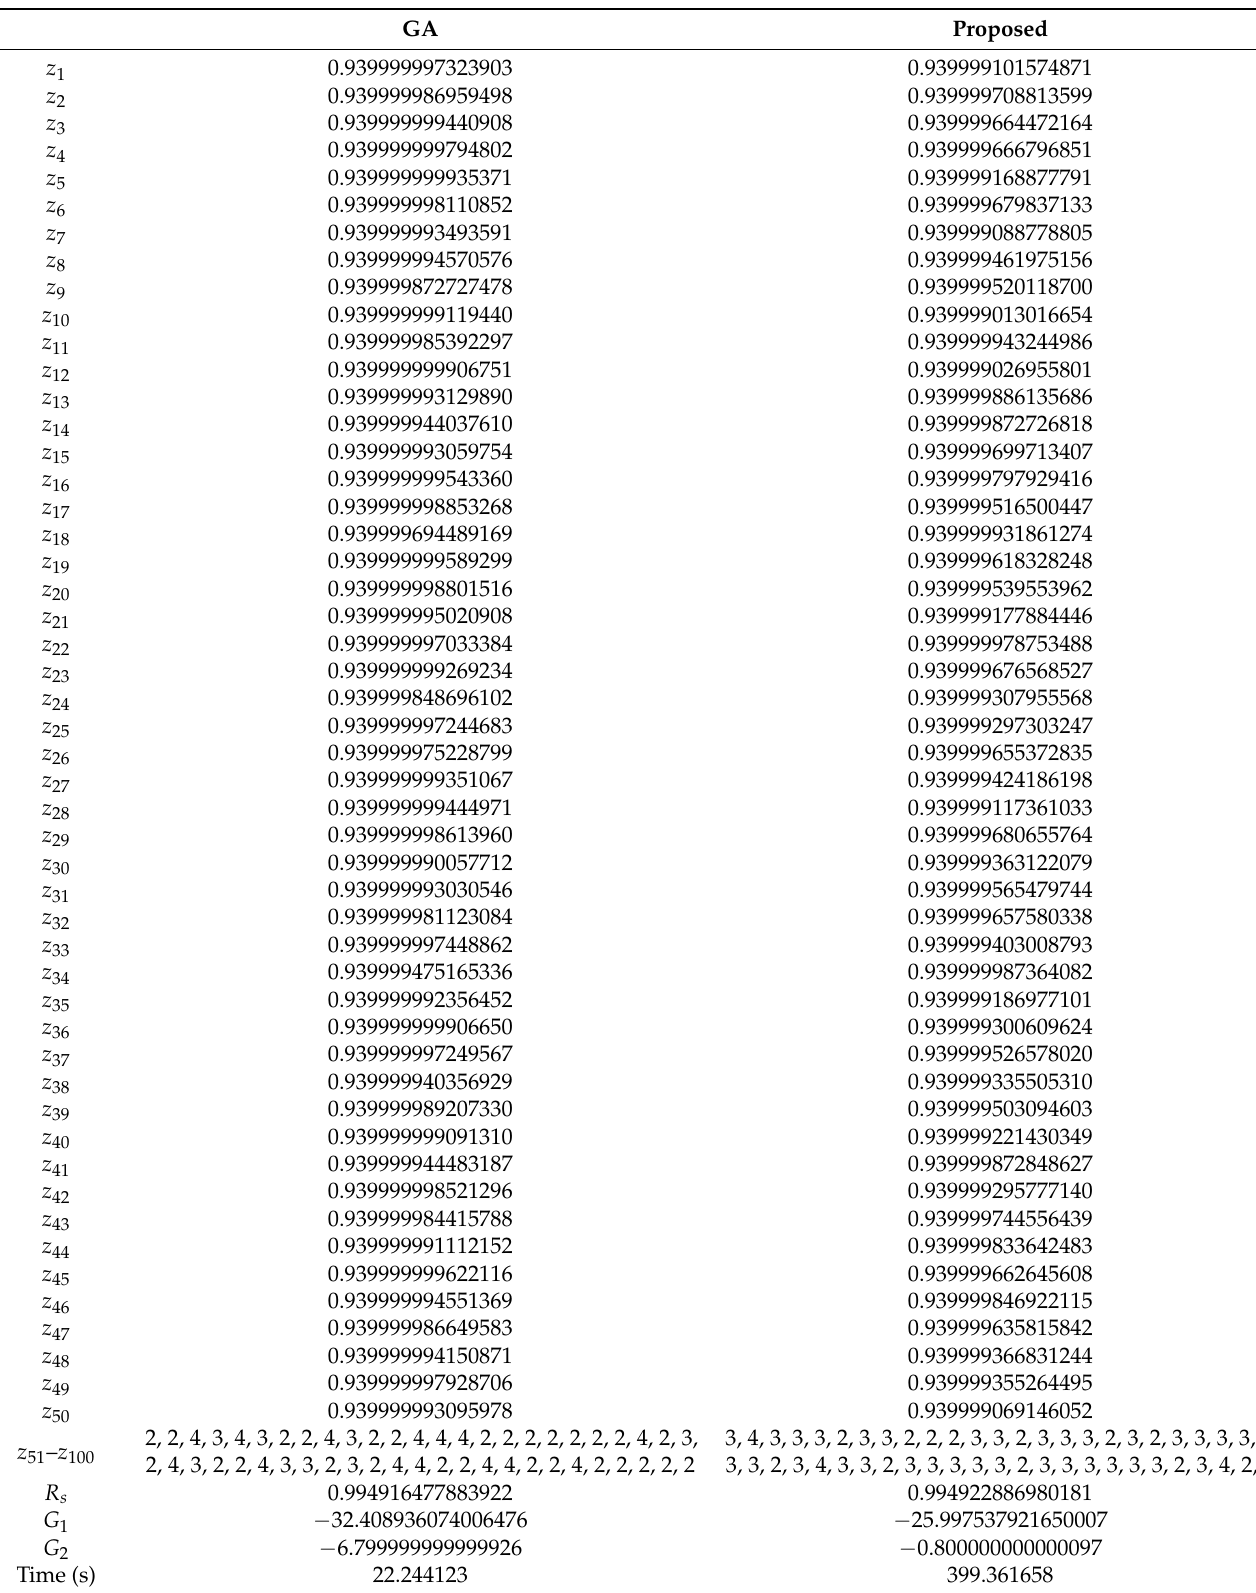
Table 2. Optimal solutions of the Lin/Con/3/50:F